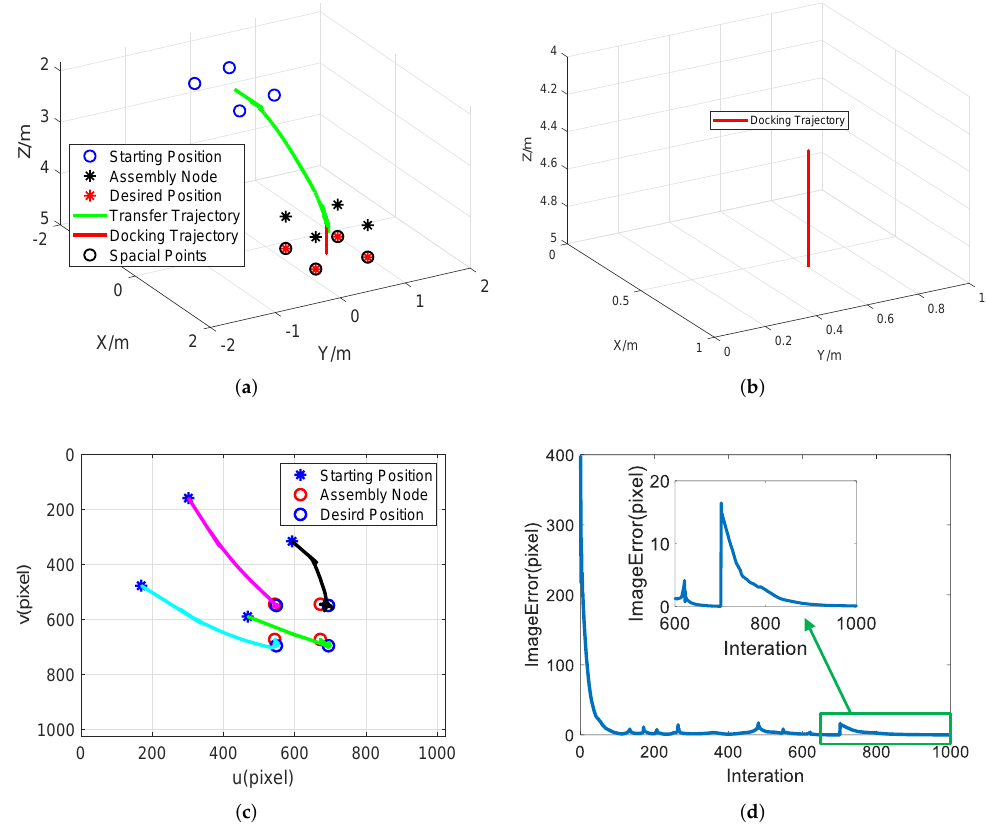
Figure 10. Results of the last simulation: ( a ) Complete Spatial trajectory of the robotic arm. ( b ) Dock- ing trajectory. ( c ) Image trajectory. ( d ) Position error in the